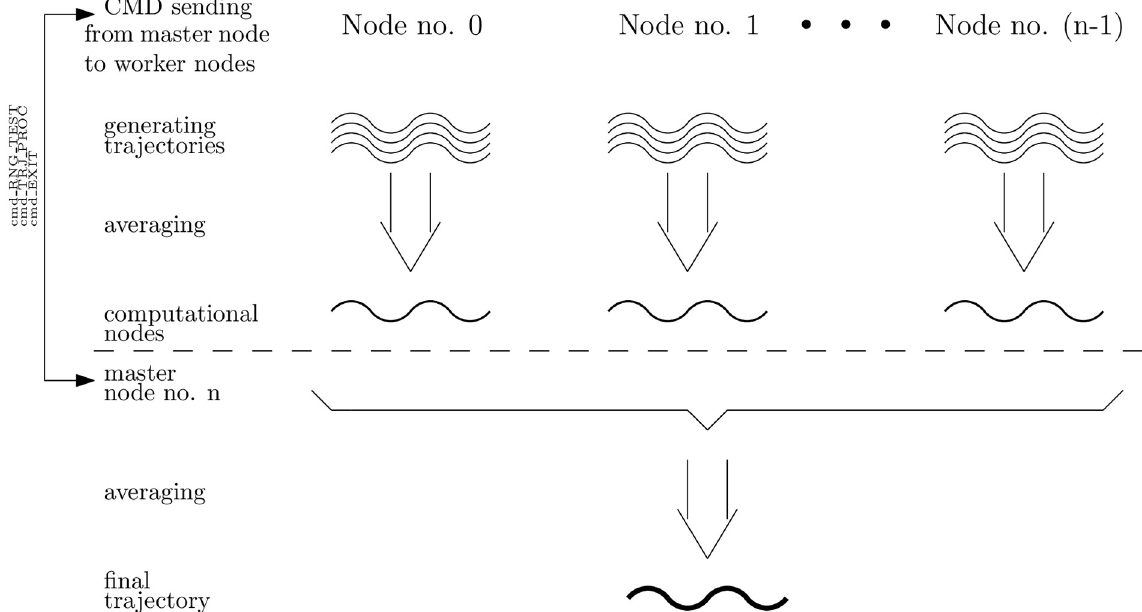
Fig 2. Computing and averaging trajectories with n + 1 computational nodes. We assume that n nodes calculate trajectories, and one node (denoted as node n ) plays a master role—it coordinates the process of computations for the QTM. The figure presents also the general scheme of message passing during the realization of the QTM. The master node sends tasks, e.g. commands to calculate trajectories, and computing nodes response with results of their calculations.